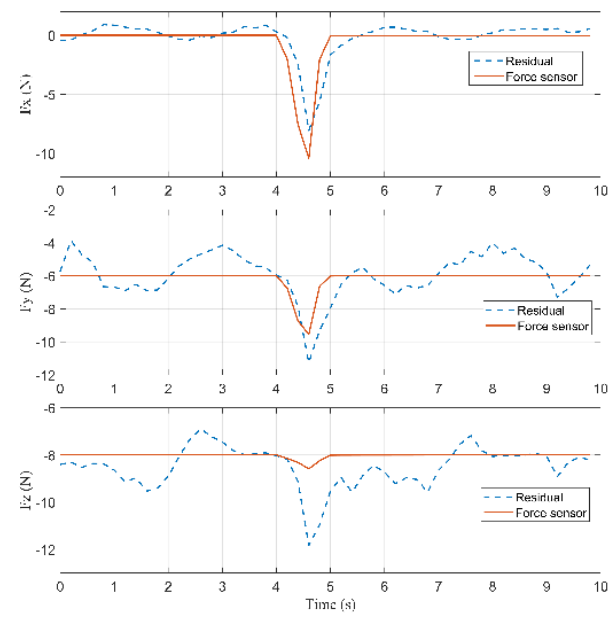
Figure 20. Current signal measured from current sensors in Case 3: (a) The 1 st , 2 nd , and 3 rd sensor; (b) the 4 th , 5 th , and 6 th sensor.